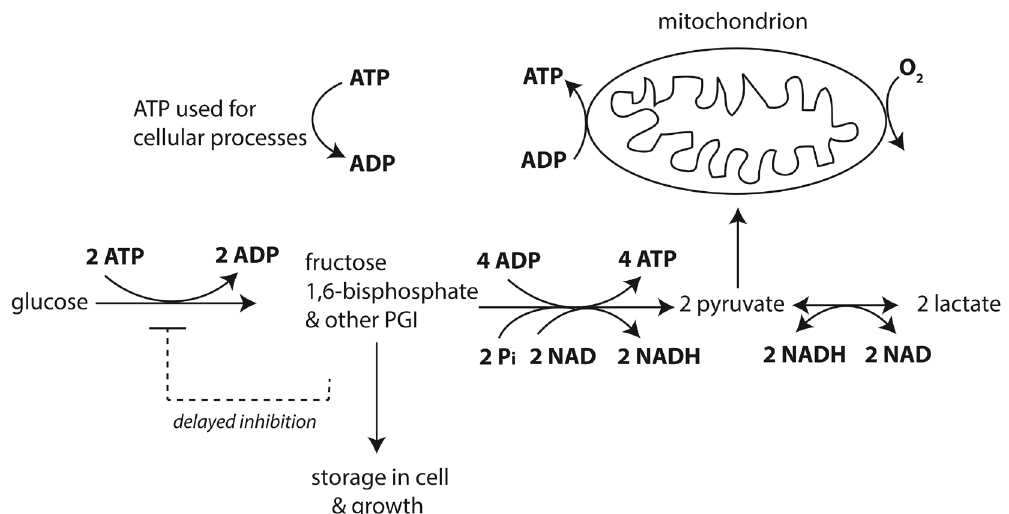
Figure 1. Scheme of computational model of tumor cell metabolism. In the head section of glycolysis, 2 ATP are spent to phosphorylate glucose, resulting in phosphorylated glycolytic intermediates (PGI) with fructose 1,6-bisphosphate (FBP) as major species. In the tail section of glycolysis four ATP, two reduced nicotinamide adenine dinucleotide (NADH) and two pyruvate molecules are produced per metabolized FBP and two inorganic phosphate (P ) molecules are taken up. Pyruvate molecules can be converted to lactate while producing oxidized i NAD. Pyruvate and NADH are also substrates for mitochondrial oxidative metabolism. ATP is used for growth, proliferation and maintenance tasks such as ion pumping. Increased NADH concentration reduces flux in the tail section. Signals from the PGI pool inhibit the head section with a time